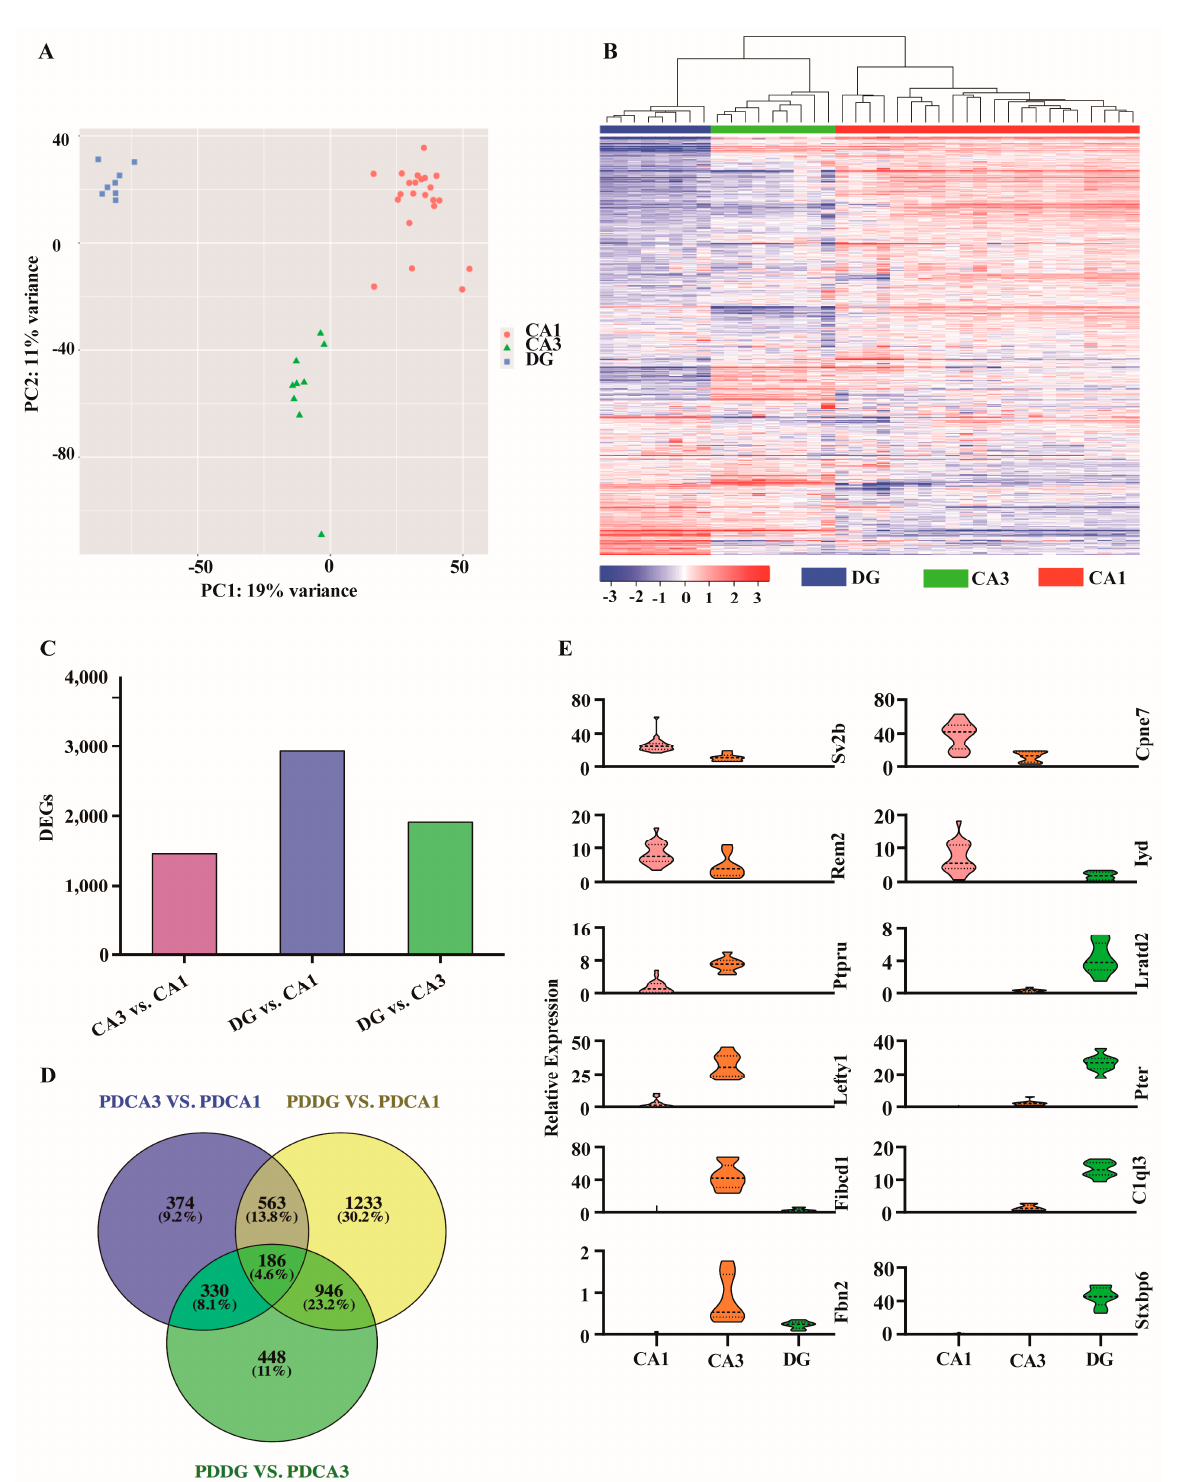
Figure 4. Gene expression characteristics in the hippocampus of PD. ( A ) Principal component analysis of single-cell samples from different subregions. ( B ) Heatmap of expression of all genes in single cells of different subregions. ( C ) Differential expression analysis between different subregions. ( D ) Co- expression analysis of differentially expressed genes between different subregions. ( E ) Analysis of specific highly expressed genes in CA1, CA3 and DG subregions.